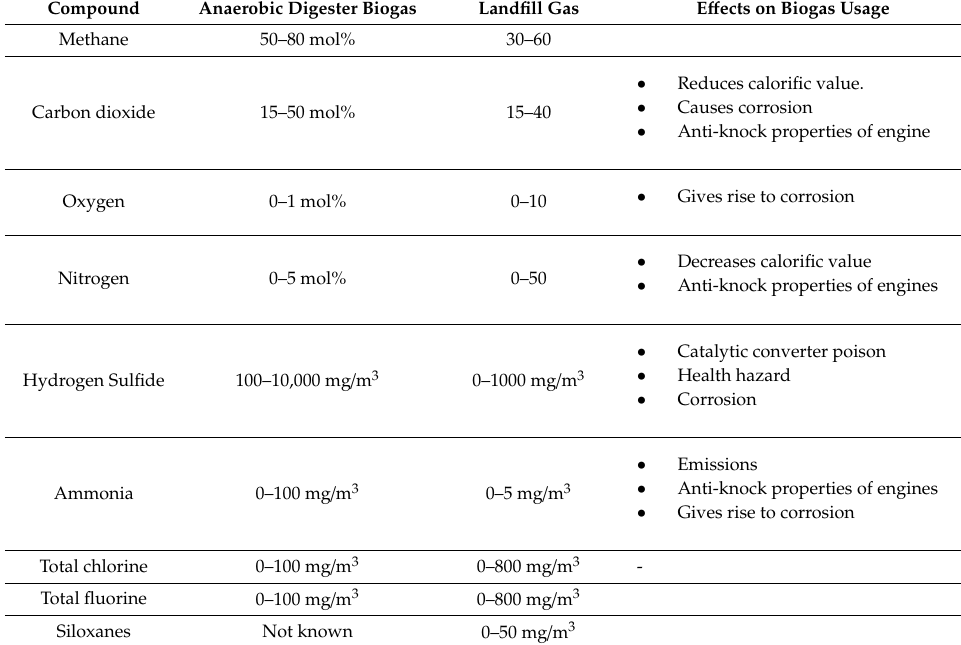
Table 1. The composition of biogas from anaerobic digester and landfill gas [9,10]. Adapted from [9], Woodhead Publishing: 2013 & [10] Elsevier: